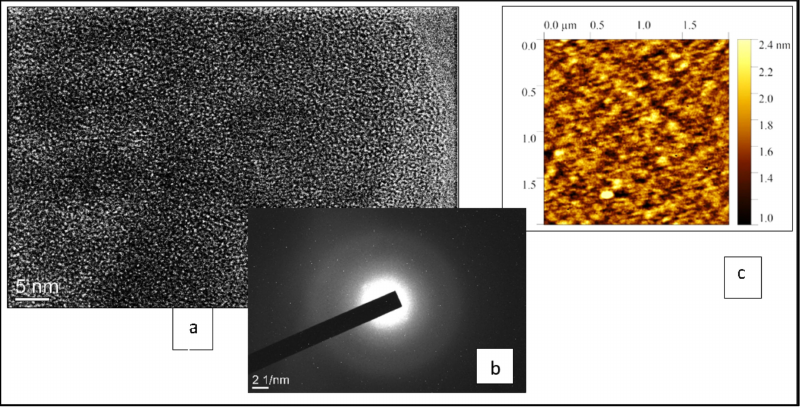
Figure 2. TEM and AFM analysis of superficial nanoscale GPS-var structure: ( a ) TEM image of the surface nanolayer; ( b ) electron diffraction pattern of the surface nanolayer. ( c ) AFM image of a fragment of the surface of the GPSi-var